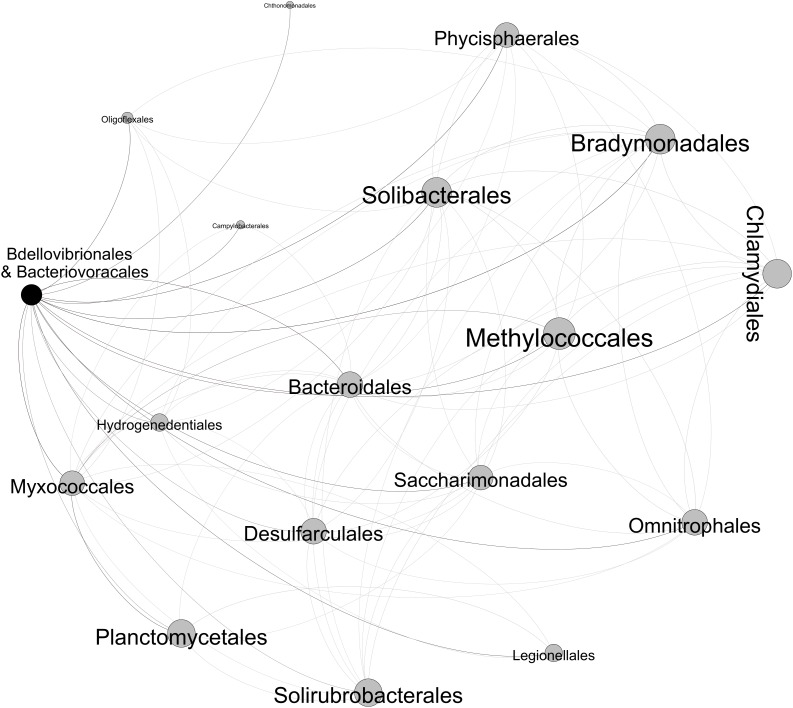
Co-occurrence network revealing the positive relationships between the BALOs and the other bacterial orders.